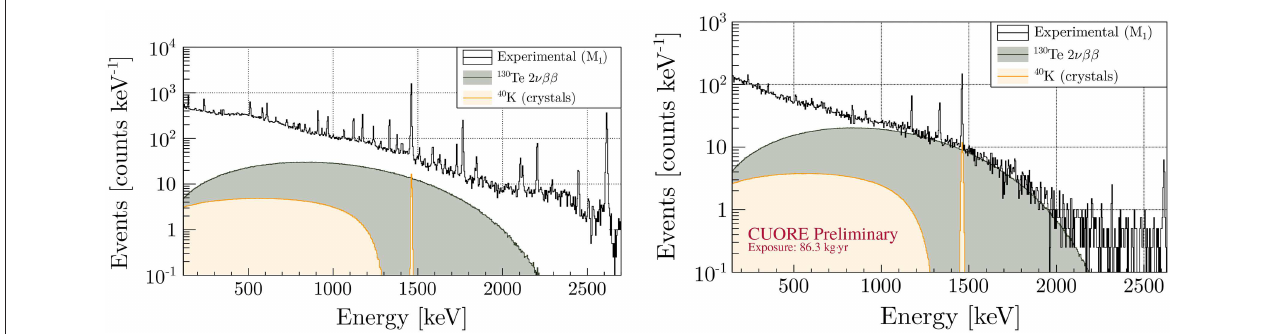
FIGURE 10 | CUORE-0 (Left) and CUORE first data release (Right) spectra compared to the 2 νββ contribution predicted by the reference fits. The 40 K peak from the crystal contamination (the radioactive source that has the strongest correlation with the 2 νββ ) is also reported. Figures from Alduino et al. [9] and Ouellet